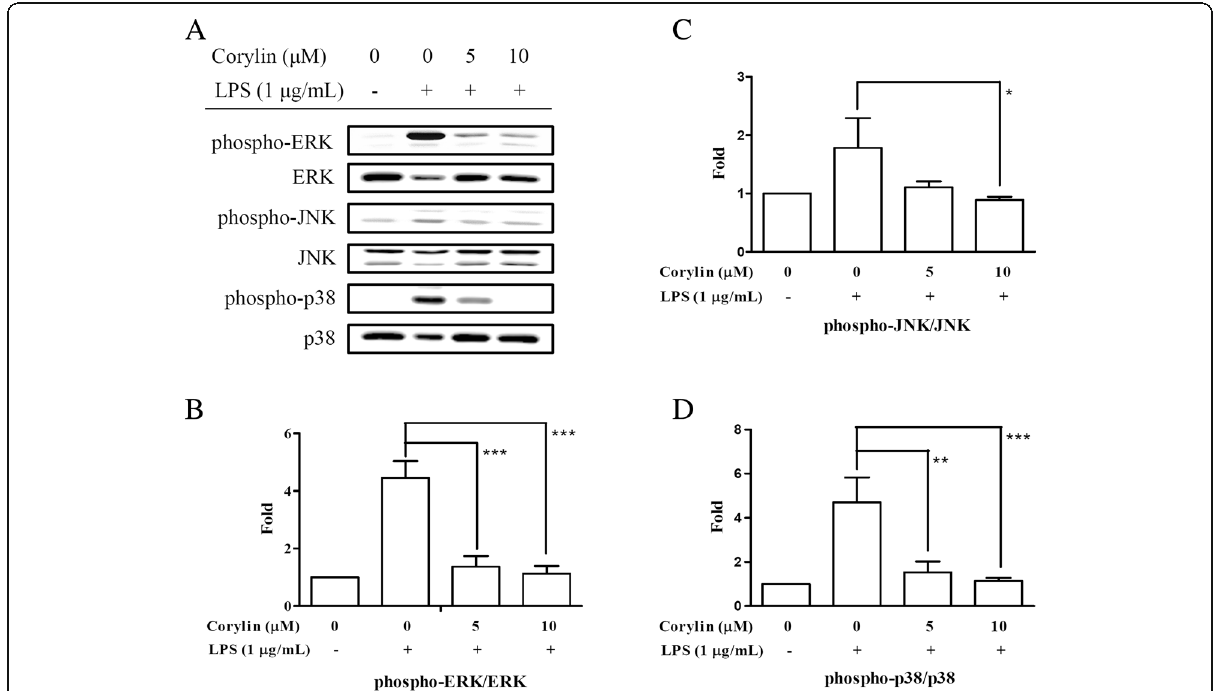
Fig. 3 Effects of corylin on MAPK signaling pathway by LPS-activated BV2 cells. Cells were incubated with various doses of corylin for 1 h, and then treated with LPS (1 μ g/mL) for 24 h. a Western blot analysis of phospho-JNK, JNK, phospho-p38 MAPK, p38 MAPK, phospho-ERK and ERK. Blots are representative blots. b , c , d Quantitation was performed on three independent experiments and presented as the means ± SD. The relative fold was phosphorylation to dephosphorylation ratio and compared to untreated samples (*: p <0.05; **: p <0.01; ***: p <0.001 vs. LPS alone)